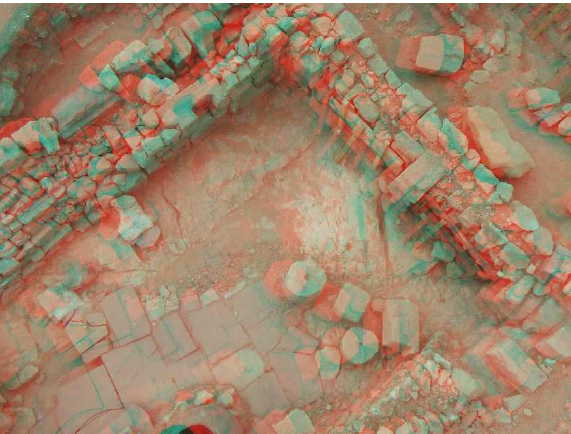
Figure 4. UAV-based anaglyphic stereo image pair (cyan/red) at Doliche displayed as anaglyph 3D